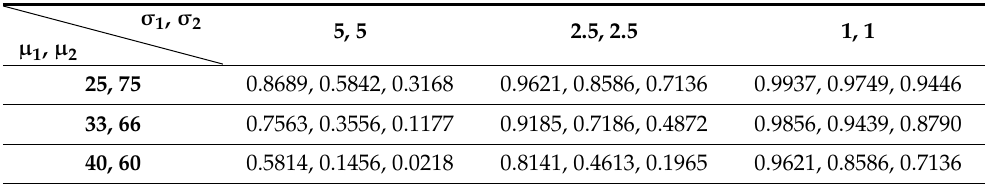
Table 2. Values for GBC 1 , GBC 2 , and GBC 3 for a binormal distribution with means µ 1 , µ 2 and variances σ 2 , σ 2 . 2 1